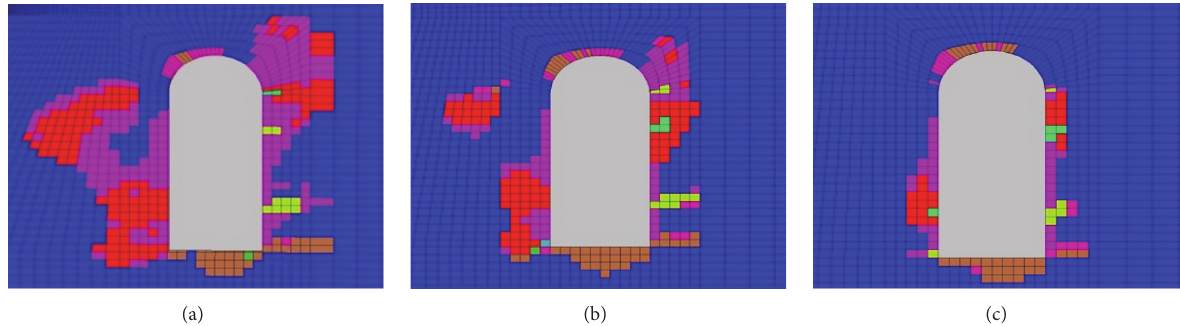
Figure 15: Plastic zones in the three schemes when the lateral pressure coefficient is equal to 1.5: (a) scheme I; (b) scheme II; (c) scheme III.